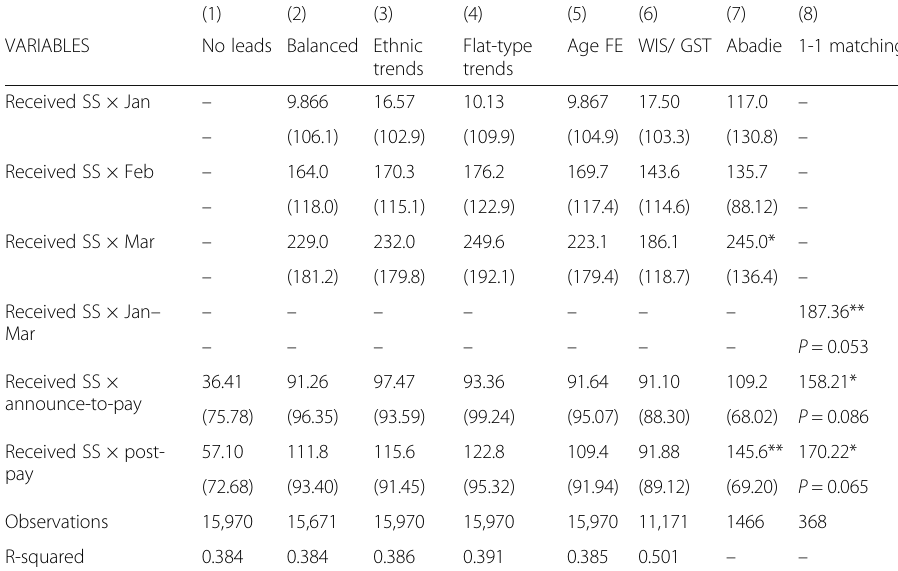
Table 26 Robustness check for impact of receiving SSS payouts on total